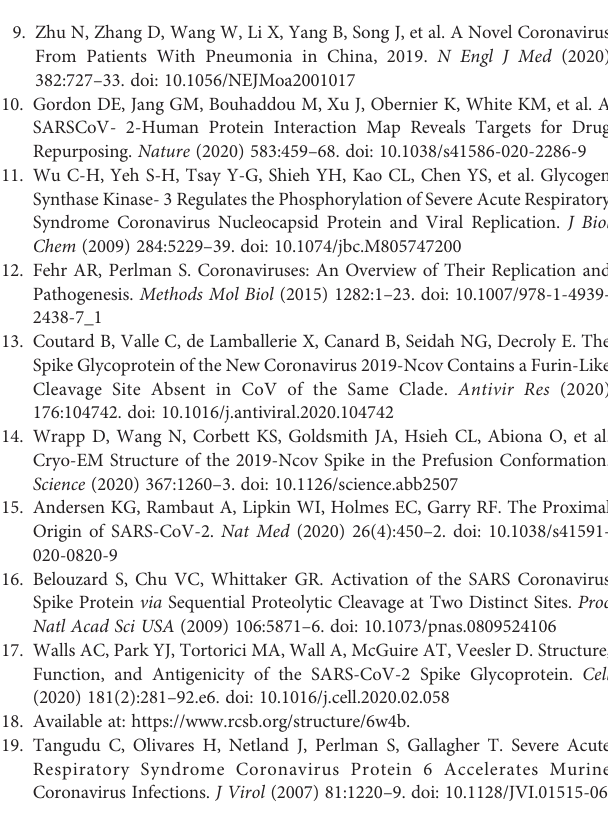
Supplementary Figure 1 | (A) Phosphosites detected in SARS-CoV-2 infected host cell line Protein. (B) Phosphosites and (C) Phosphoproteins detected in SARS-CoV-2 Proteins. Supplementary Figure 2 | (A) Phosphosites Spike glycoprotein (S) of SARS-CoV-2, (B) Phosphosites inSARS-CoV-2 ProteinonSerine(S), Threonine (T) and Tyrosine (Y) on Spike protein of SARS-CoV-2. Supplementary Figure 3 | Phosphosites in (A) Membrane protein (M), (B) ORF9b protein (9b), (C) ORF3a protein (3a), (D) Replicase polyprotein 1ab (Rep) of